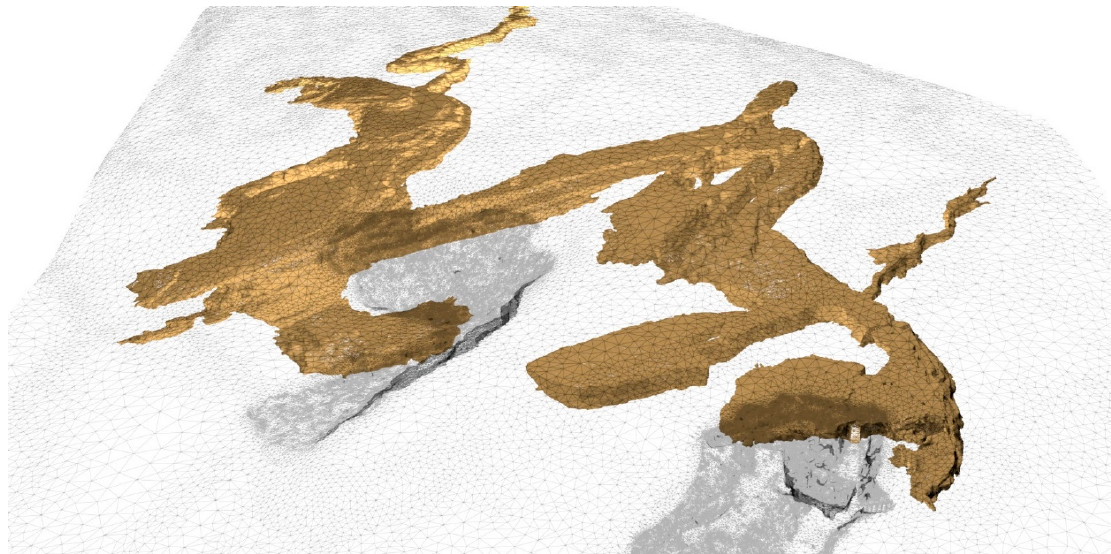
Figure 10. Visualization of the 3D model of the cave below a low ‐ detail mesh obtained from UAV model.